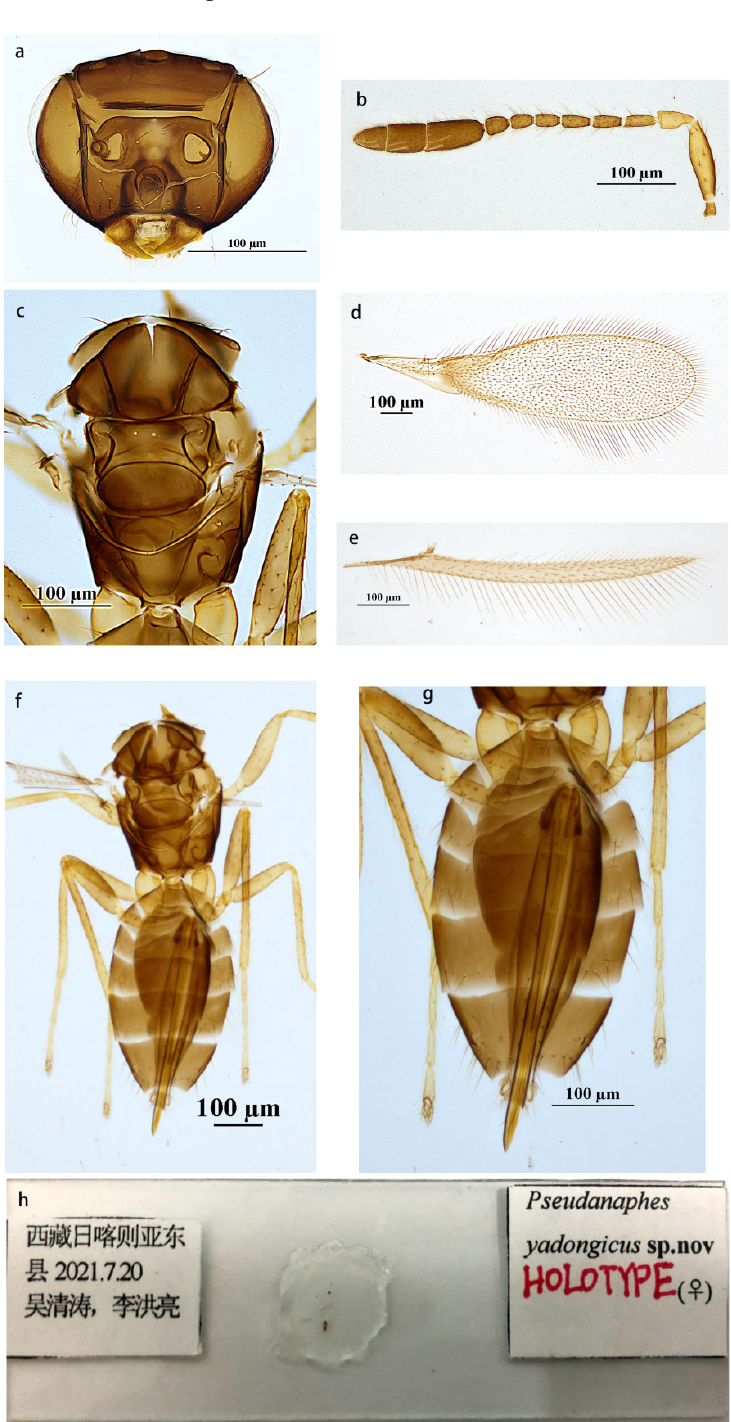
Figure 2. Pseudanaphes yadongicus sp. nov. female. ( a ) Head; ( b ) antenna; ( c ) mesosoma in dorsal view; ( d ) fore wing; ( e ) hind wing; ( f ) body in dorsal view; ( g ) metasoma in dorsal view; ( h ) holotype slide.